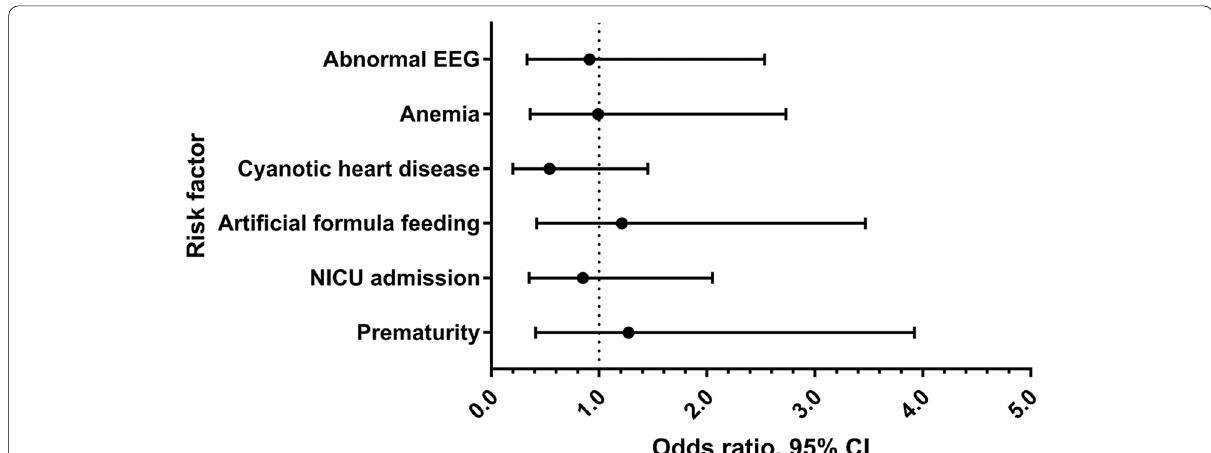
Fig. 2 Odds ratio for various risk factors. Rounded markers represent estimates. Error bars represent 95% confidence limits. Dotted vertical line represents line of equality (odds ratio of 1.0). A total of 95% confidence limits including the value 1.0 are not statistically